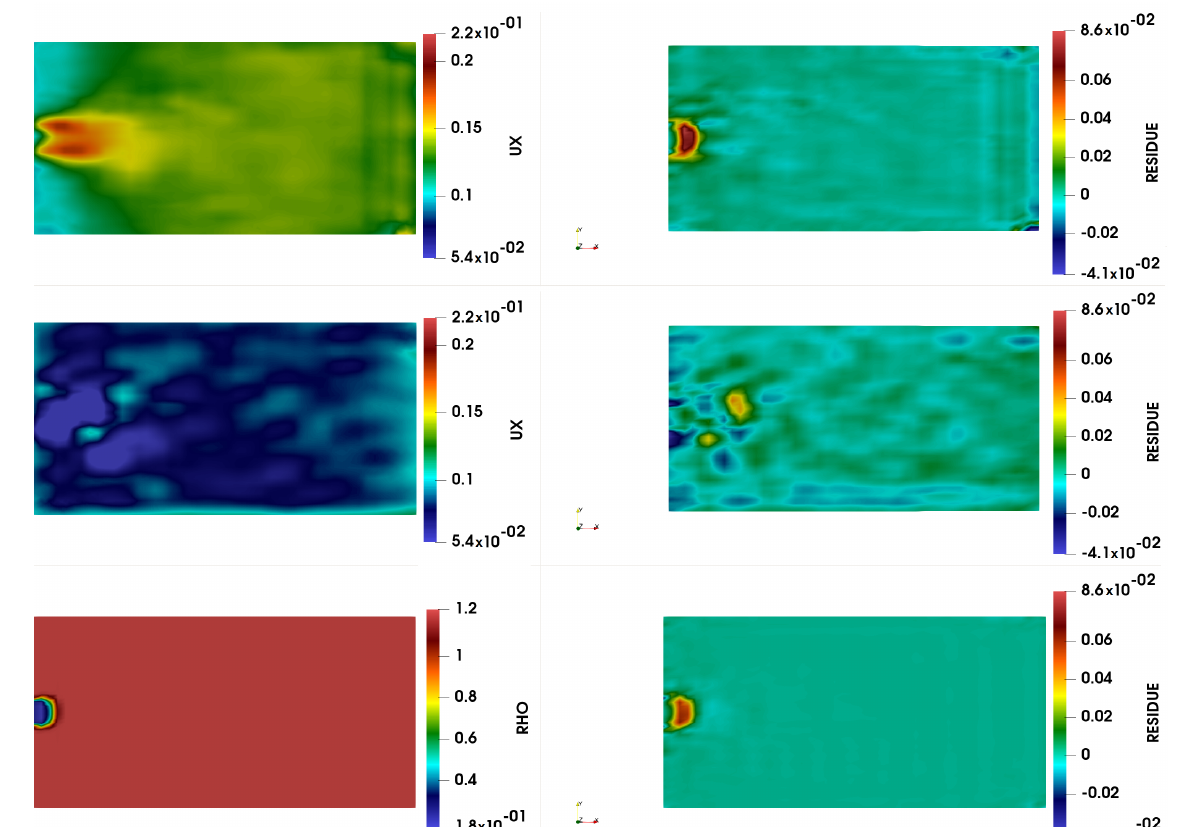
Figure 21. On the top left, the 202-th decoder generation µ h ( t ) ∼ p θ ( µ h ( t ) | z ) from a sample of the probability distribution p θ ( z ) for the data-targeted VAE. On the top right, the residue of this generated sample, ∂ρ h ( t 202 ) middle left, the 202-th decoder generation µ h ( t ) ∼ p θ ( µ h ( t ) | z ) from a sample of the probability distribution N ( 0,1 ) for the classical VAE. On the middle right, the residue of this generated sample, ∂ρ h left, the high-fidelity density field ρ h ( t 202 ) projected on the Cartesian mesh. On the bottom right, the accurate residue ∂ρ h ( t 202 ) + div ( ρ ( t ) u ( t )) 202 202 h h ∂ t